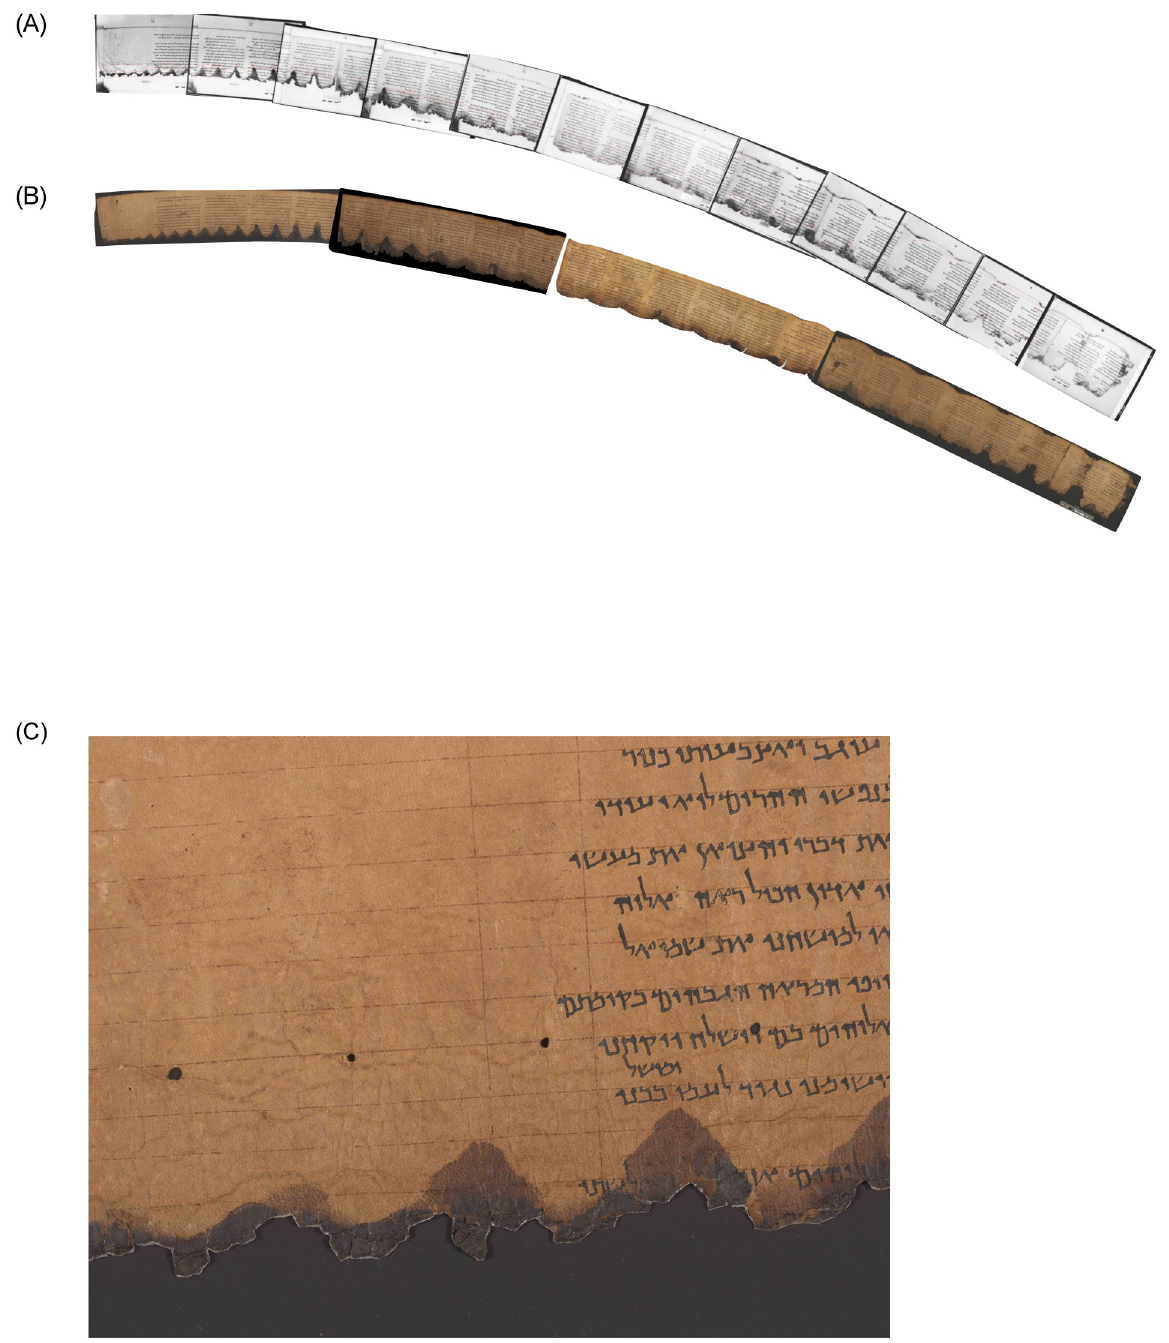
Fig 1. The Great Psalms Scroll , 11Q5. (A) Upper left: PAM infrared images with its 39 turns. (B) Lower left: IAA color images. (C) Right: closeup, showing wormholes. (Courtesy IAA, LLDSSD. IAA image photographer: Shai Halevi; PAM photographer: Najib Anton Albina.).